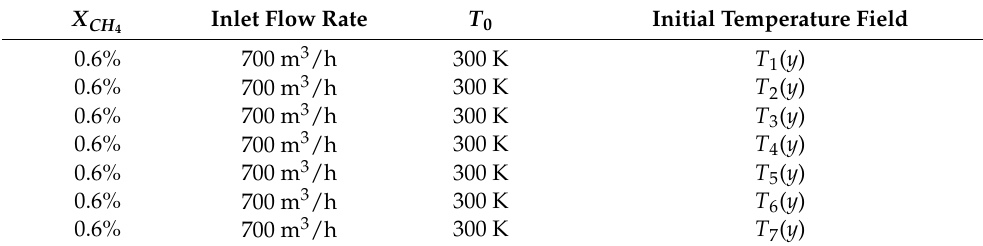
Figure 21. Variation of flame thickness with time at different initial temperature field peaks with the inlet flow rate of 700 m 3 /h, X CH = 0.6%. 4 Table 5. Parameters in this